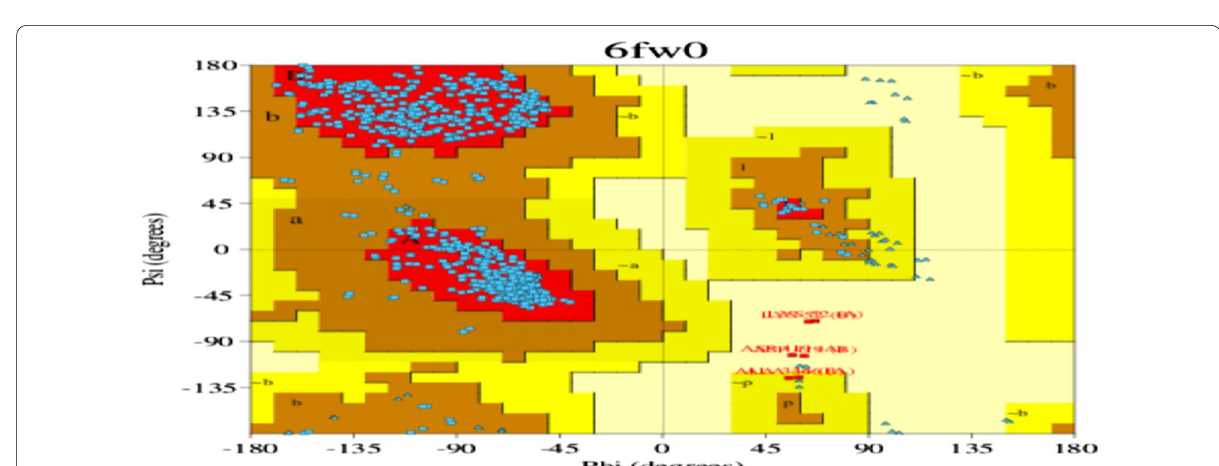
Figure 4 indicates the plot of experimental against residuals. This plot gives room to evaluate the deviations from the ideal experimental and predicted value and to detect anomalous trends. The plot shows equal distribu- tion of the data within 2 and 2, hence no anomalous + − detected which implies that the built model is brilliant and offer exceptional predictions [42].